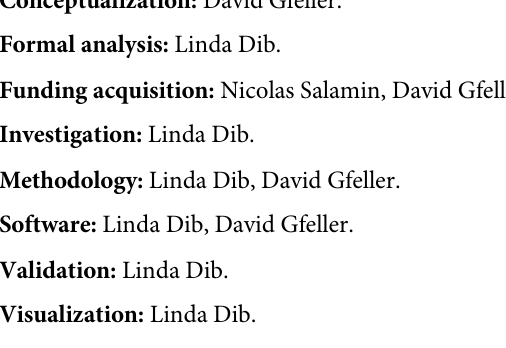
S5 Fig. Polymorphic sites preferentially avoid sites involved in protein stability and co- evolving sites. Same analysis as in Fig 3, but using only the 331 most frequent human MHC-I alleles (frequency > 0.00001 in Caucasian population) to define polymorphic sites (same threshold of 0.01 on the polymorphism score as in Fig 3). S6 Fig. Correlation between DCA scores, predicted stability and number of structural con- tacts. A. Correlation between DCA scores and stability predictions. B. Correlation between DCA scores and the number of contacts for each residue. C. Correlation between stability pre- dictions and the number of contacts for each residue. S7 Fig. Co-evolution between PDZ domains and their ligands. Contact maps based on 2HE2 structure (pairs of residues at distance < 8 Å are shown in grey) summarising DCApep- tides predictions based on the alignment of 54 PDZ domains and their ligands. Chains A (PDZ domain) and P (ligands, positions -9 to 0) are both represented in the contact maps. Blue squares represent structurally close pairs of sites predicted by DCApeptides and red squares represent structurally distant pairs of sites predicted by DCApeptides. A. Co-evolution signal using the full alignment of human PDZ and their associated ligands (top 25 pairs). B. Inter-molecular co-evolution signal between PDZ sequences and their associated ligands (top 2 pairs). S8 Fig. Polymorphism and structural contact. Comparison between the number of structural contacts with residues distant in the sequence (more than 4 amino acids) for polymorphic and non-polymorphic